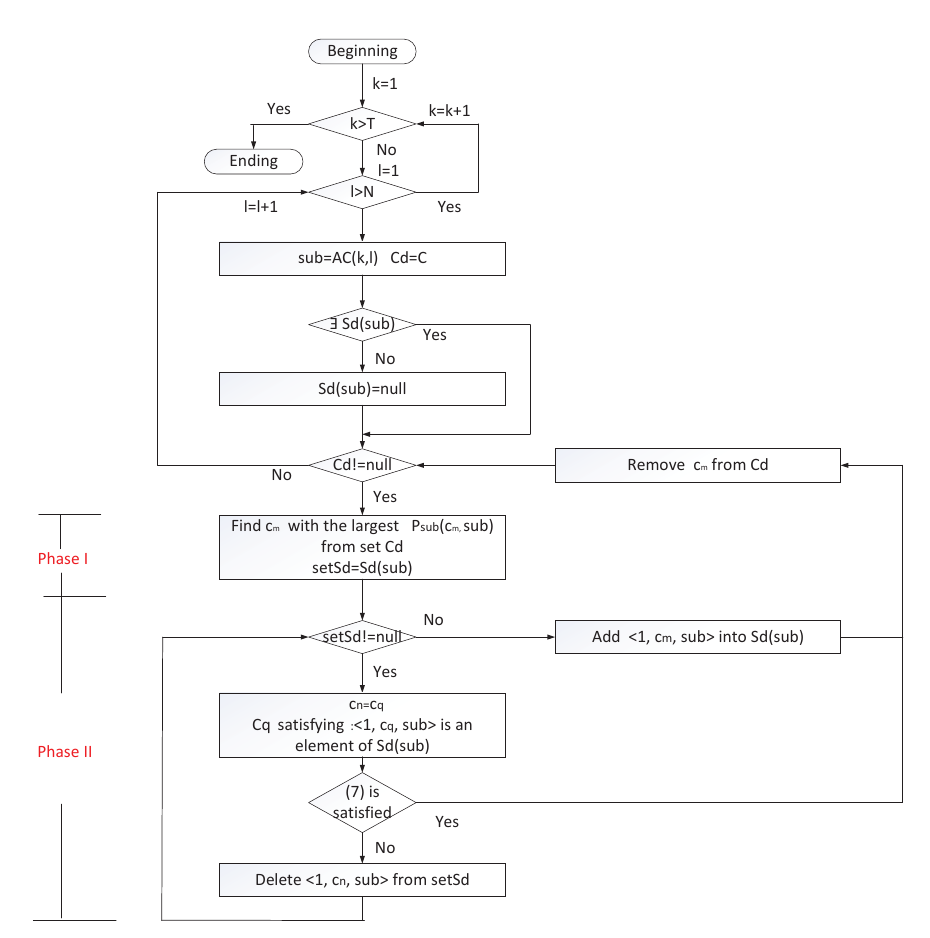
Figure 6. The flowchart of correlation mining between a command and a